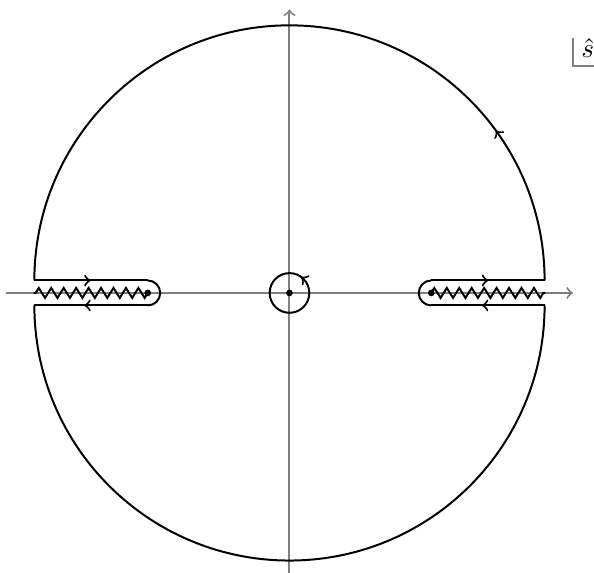
Figure 1 . The two contours in the ˆ s -plane for S -matrix argument. The integral around the origin gives the coefficient of the operator in the EFT. It is equivalent to the large contour that reduces to an integral along the cuts, since the arcs at infinity vanish. The integral along the cuts is positive